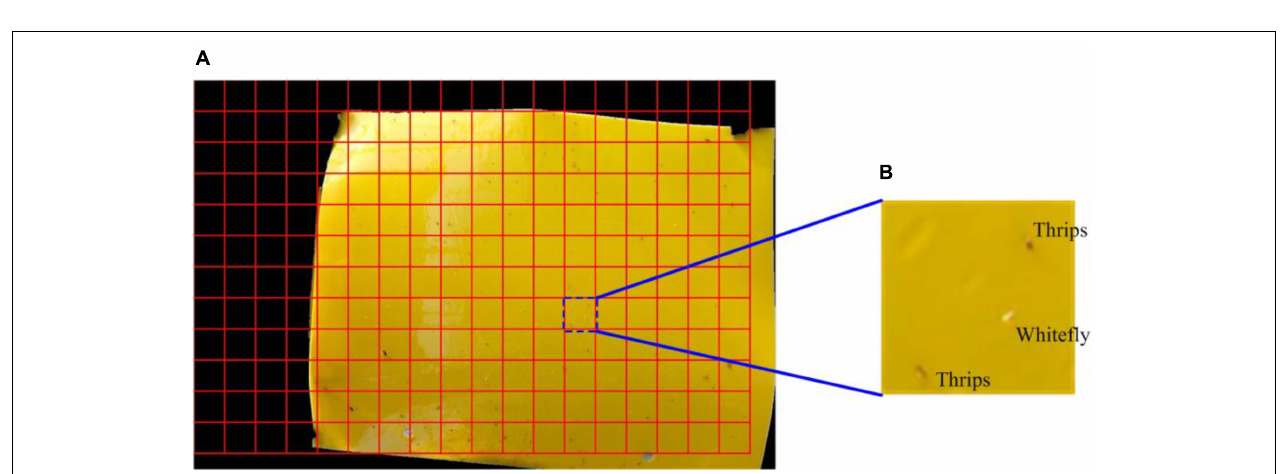
FIGURE 3 | Illustration of the sticky trap region extraction using image processing technology: (A) original image, (B) Cb component in YCbCr color space, (C) binary image, and (D) extraction result of the specific region of interest.